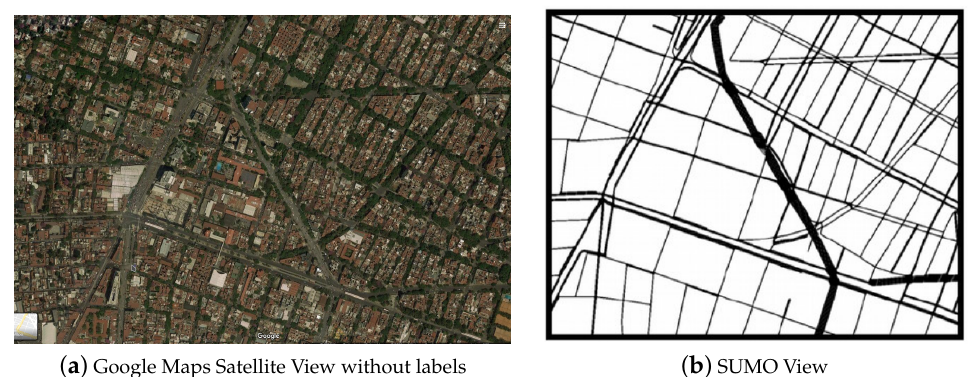
Figure 3. Detailed study area.